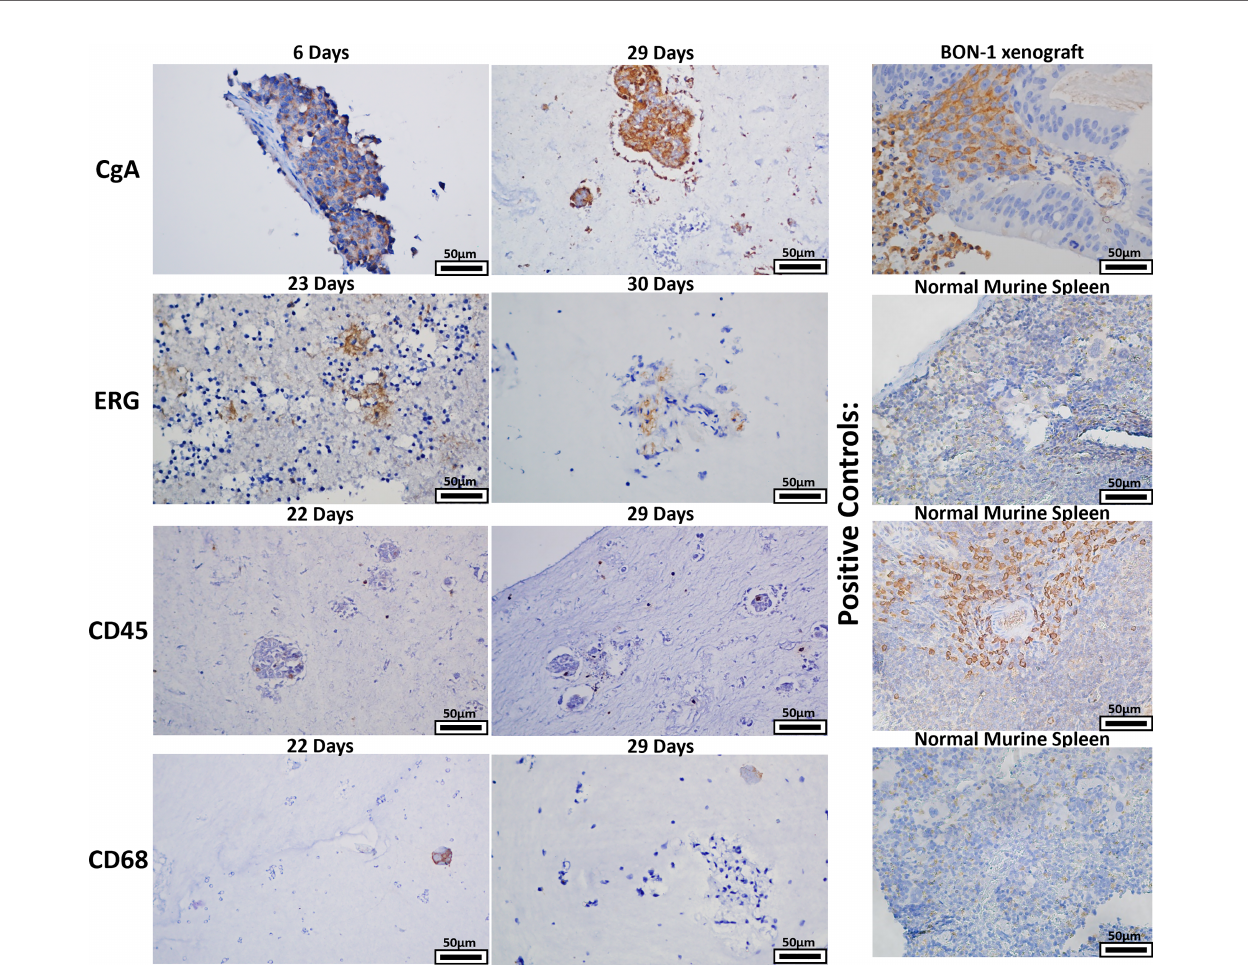
FIGURE 9 | The bioreactor system retains key stromal populations over time. Six human NETs were implanted into multiple bioreactors. Each bioreactor was cultured to multiple endpoints based on experimental need or mechanical compromise. Sections of endpoint samples were stained with four different antibodies, depicting retention of NET and stromal cells over the culture period. Panels depicted are representative histological images of the surrogate